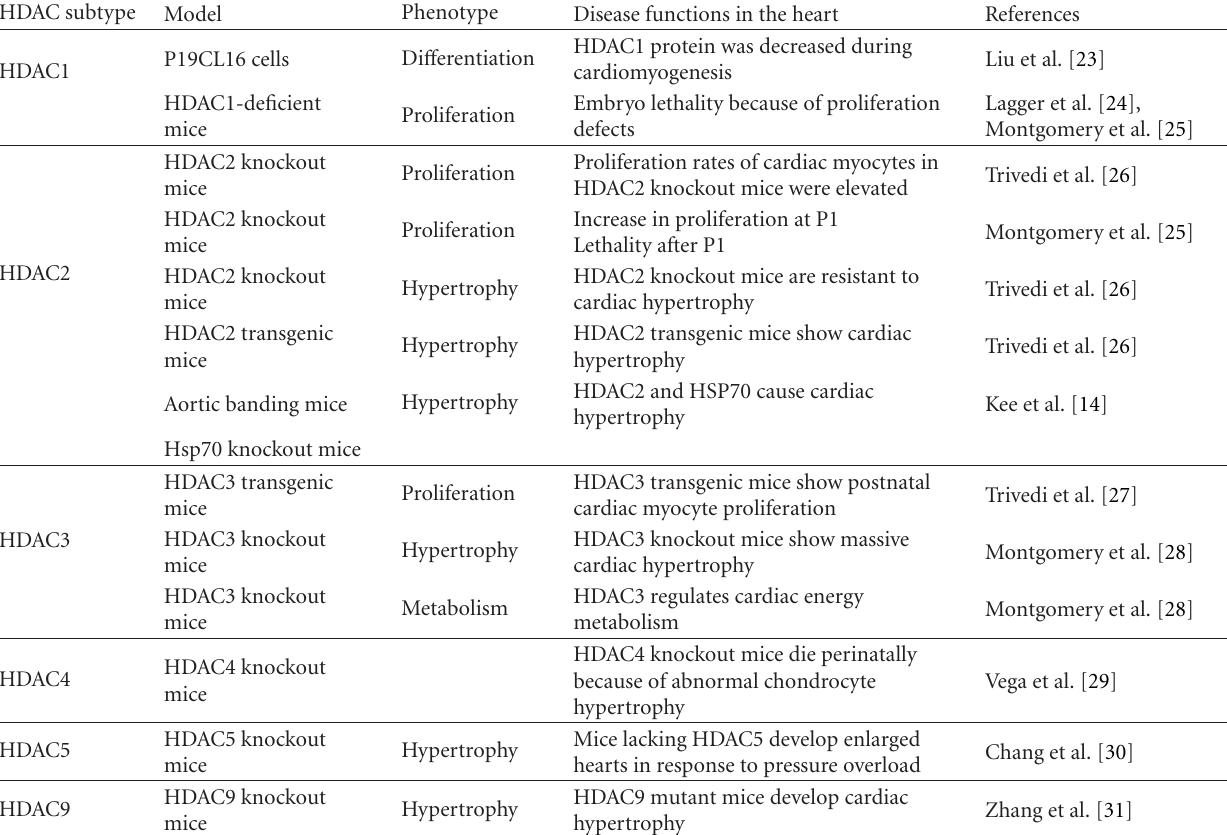
Table 1: The physiological role of class I and class IIa HDACs in cardiac development and heart